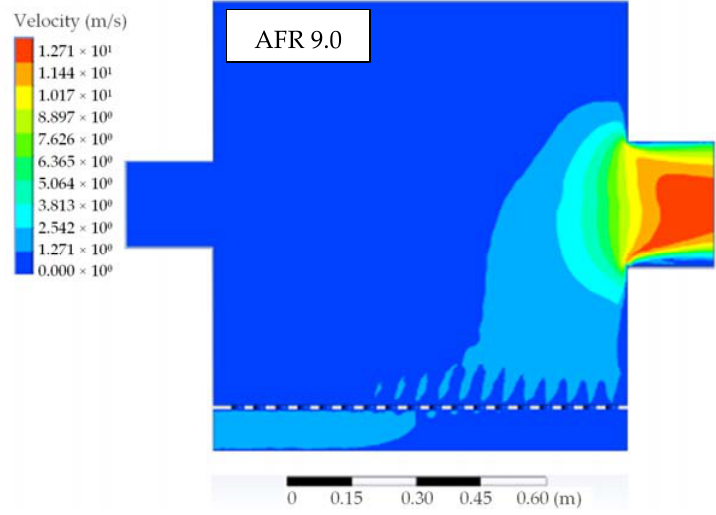
Figure 8. Combustion gas speed.